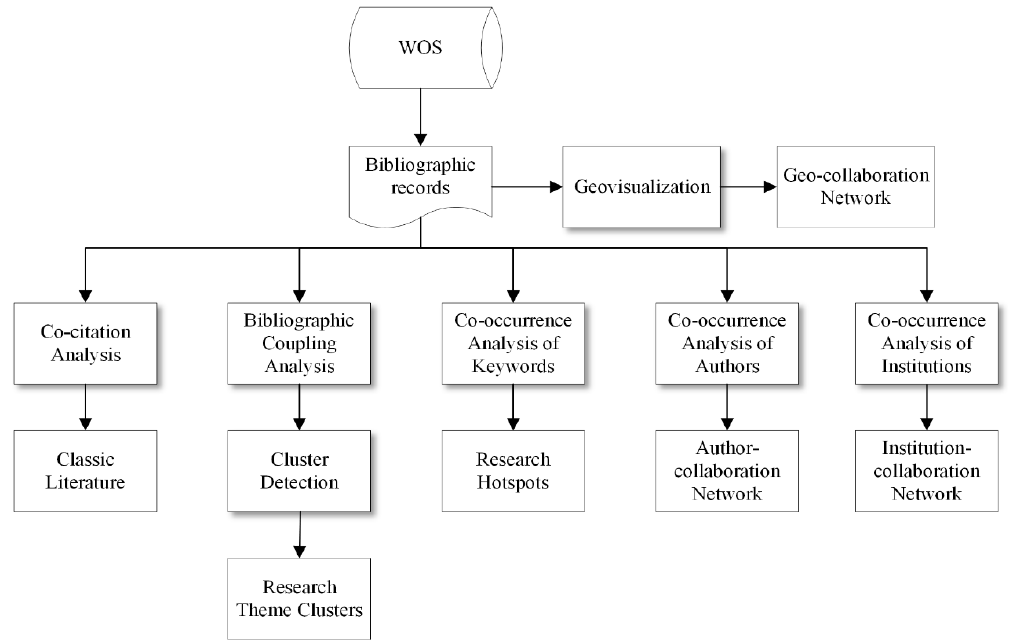
Figure 1. Workflow of the analysis process.